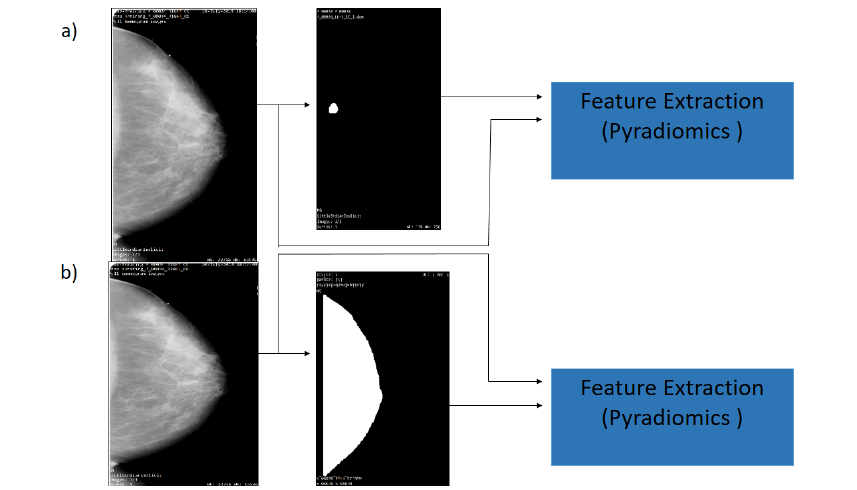
Figure 4. Flowchart of the mammography segmentation. ( a ) Original image and ROI Segmentation ( b ) Original image and whole breast